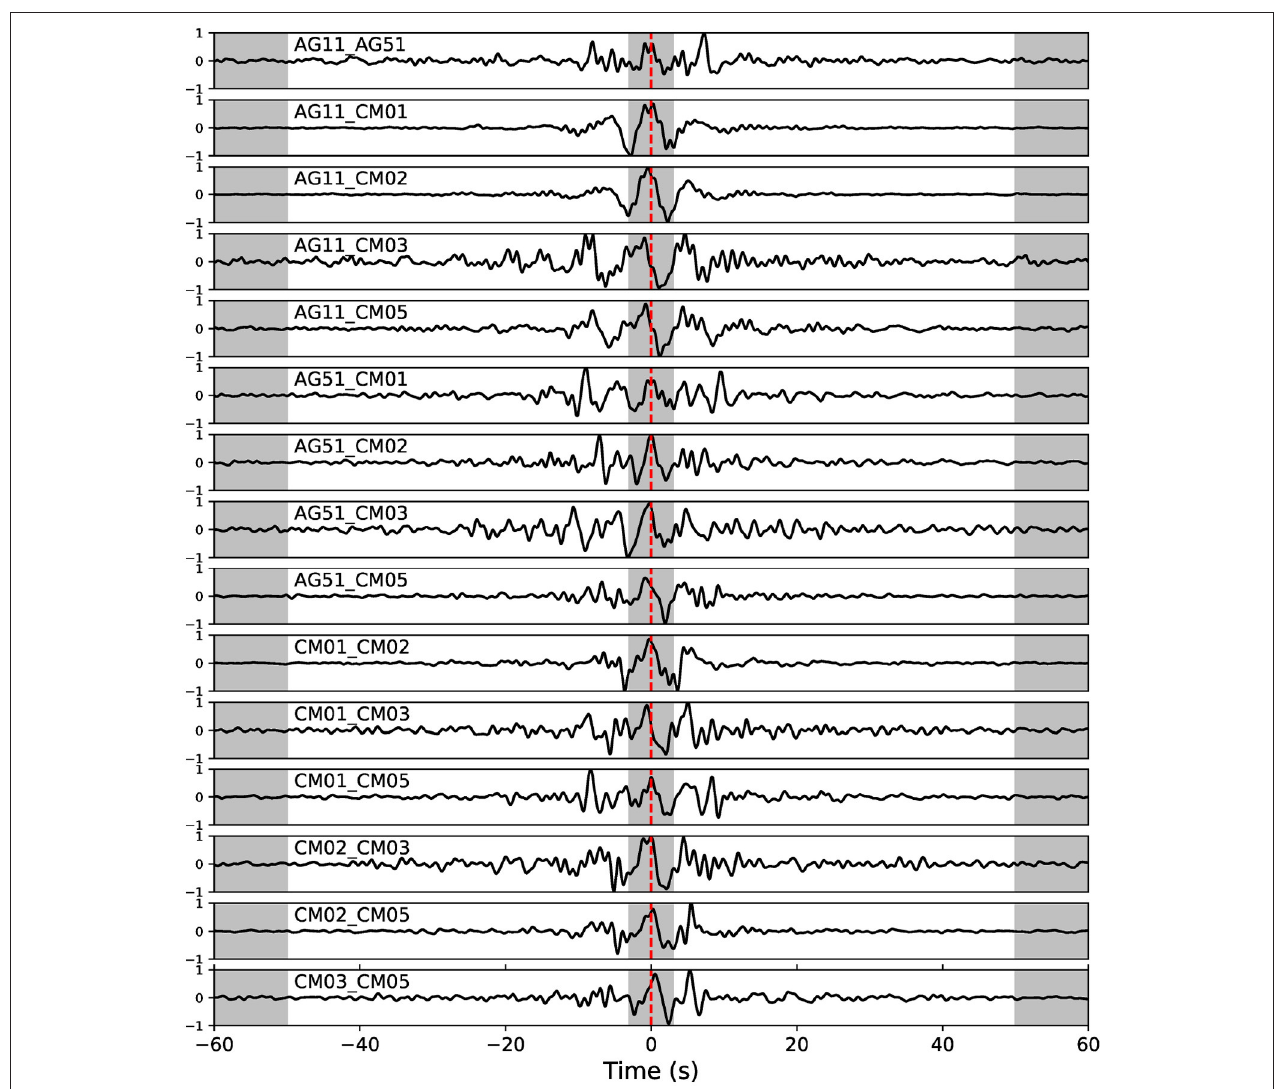
FIGURE 5 | Reference cross-correlations for all the station pairs available. Gray areas are the part of the signal excluded from the